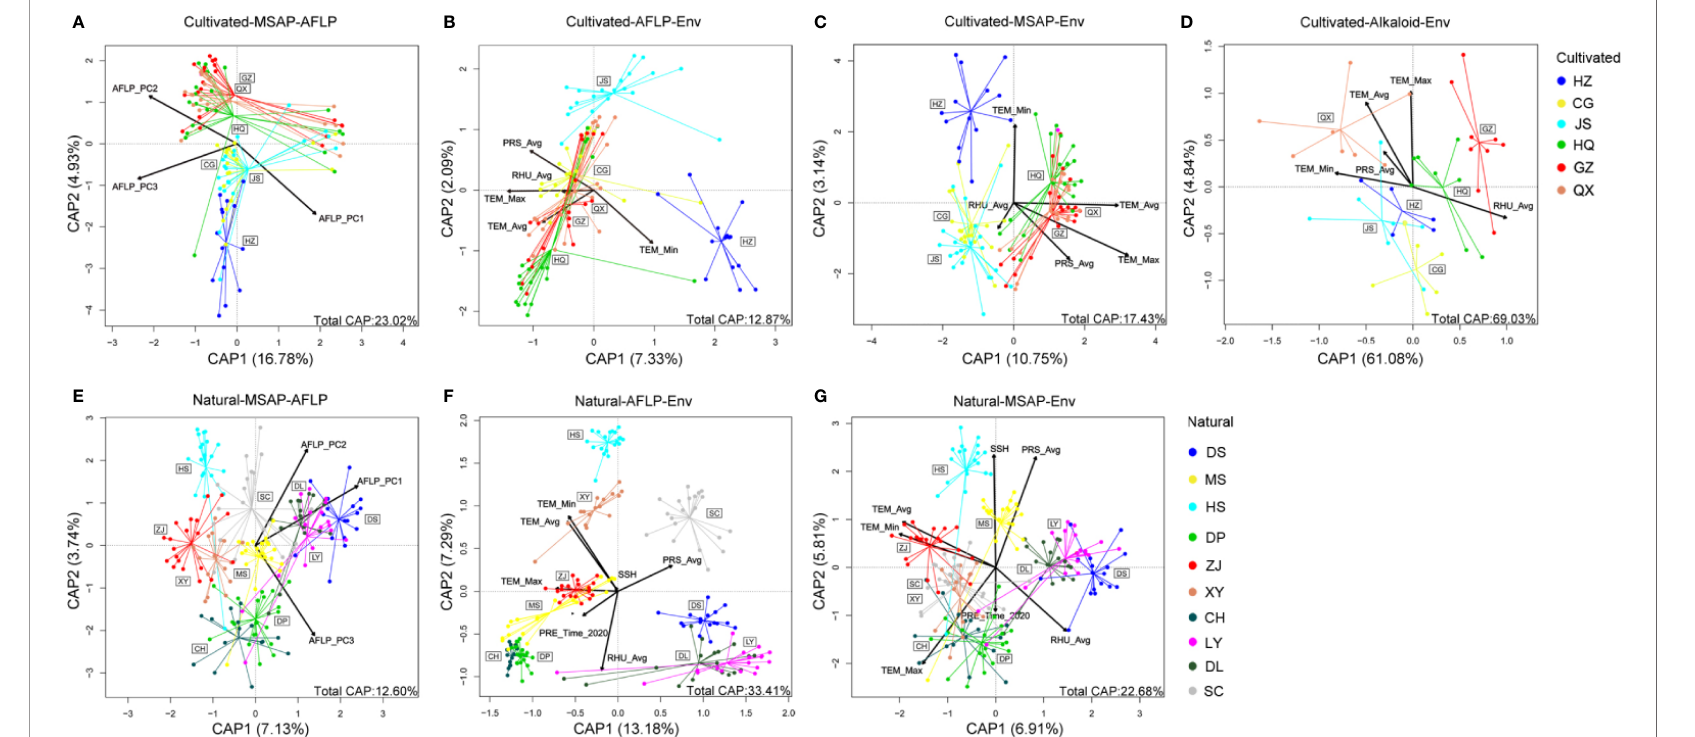
FIGURE 6 | The relationships among epigenetic, genetic, alkaloids, and environmental variations using distance-based redundancy analyses (dbRDA). (A) epigenetic variation in cultivated populations of C. yanhusuo using genetic data as predictor; (B) genetic, (C) epigenetic, and (D) alkaloids variation in cultivated populations of C. yanhusuo using environmental factors as predictor; (E) the epigenetic variation in natural populations of C. yanhusuo using genetic data as predictor; (F) genetic and (G) epigenetic variation in cultivated populations of C. yanhusuo using environmental factors as predictor. For genetic data used as predictors of epigenetic variation, the fi rst three PCA axes of the AFLP datasets were adopted. Environmental data include average (TEM_Avg), lowest (TEM_Min), and highest daily temperatures (TEM_Max), average daily relative humidity (RHU_Avg), average air pressure (PRS_Avg), total daily sunshine time (SSH) and total daily precipitation (PRE_Time). The percentages on the axes indicated the proportion of eigenvalues for each constrained axe, and the percentage in the bottom right corner of the graph indicated the proportion of eigenvalues for all constrained